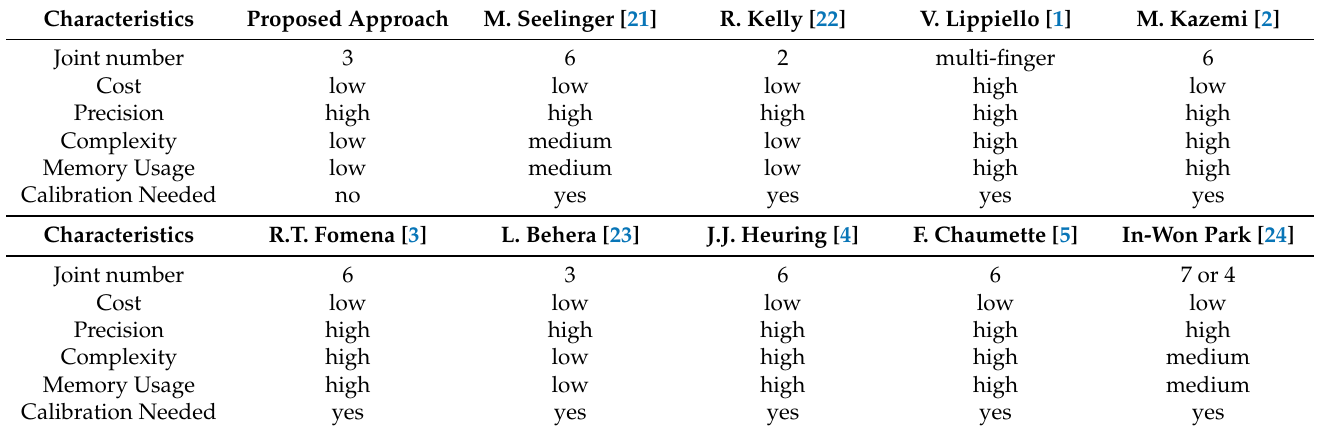
Table 1. Comparison between the presented method and other similar